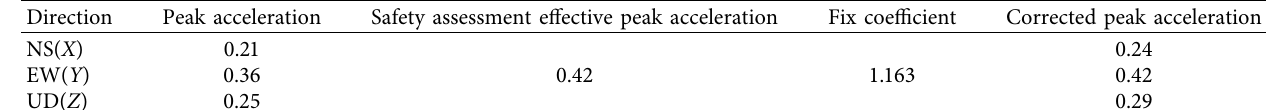
Table 2: Peak acceleration correction value (g).